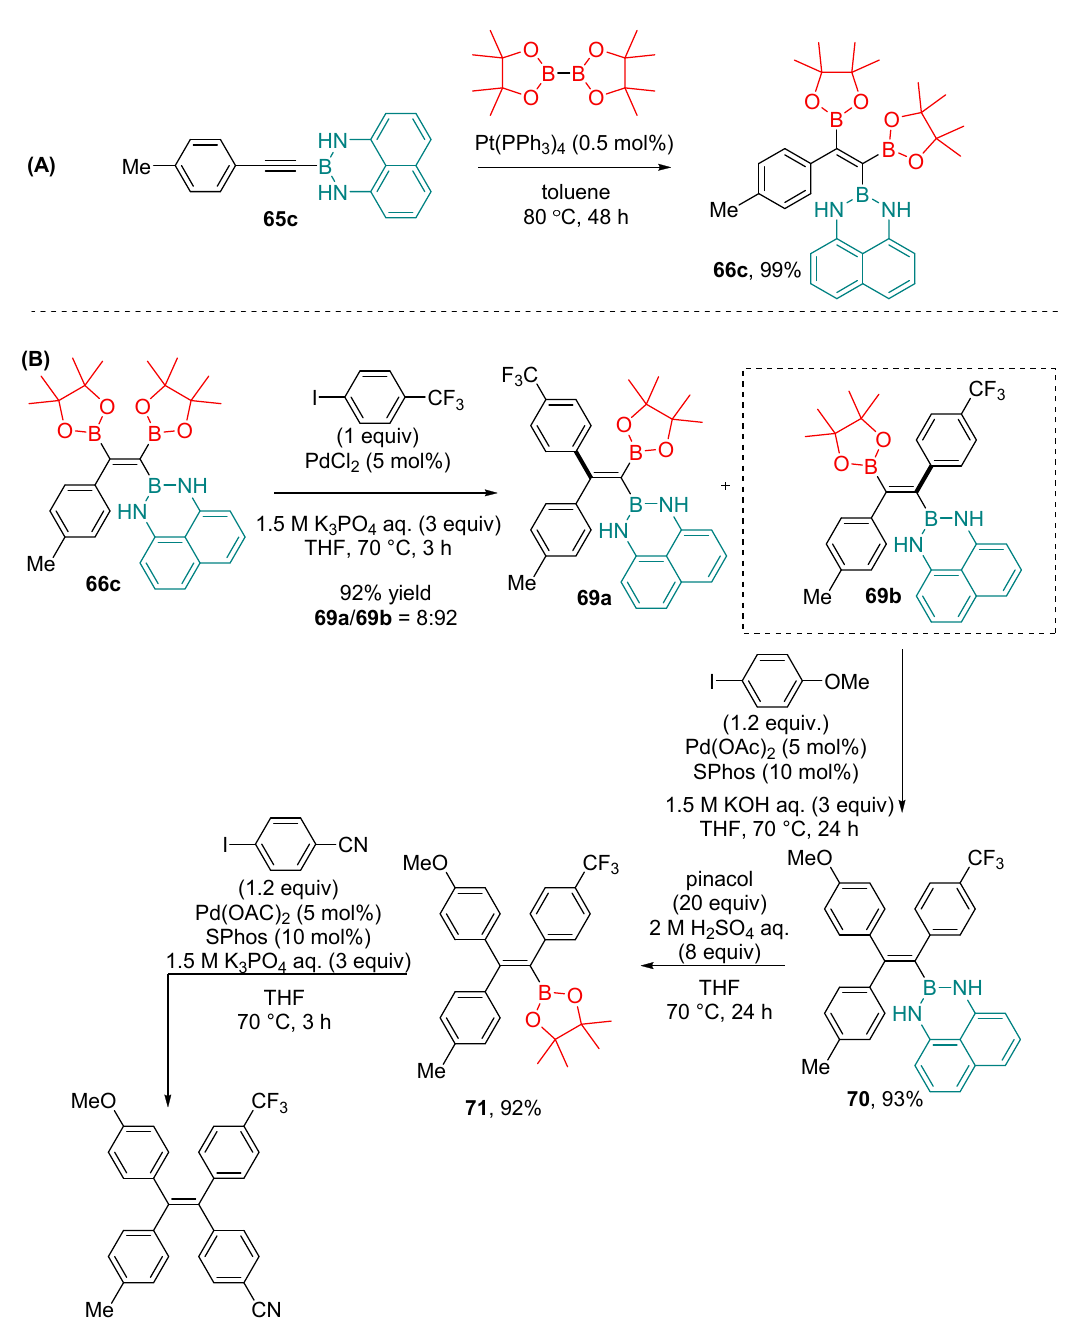
Scheme 30. ( A ) Platinum-catalyzed 1,2-diboration of alkyne with B 2 (pin) 2 ; ( B ) Suzuki–Miyaura cross- coupling reactions to afford the tetra-arylalkene 72